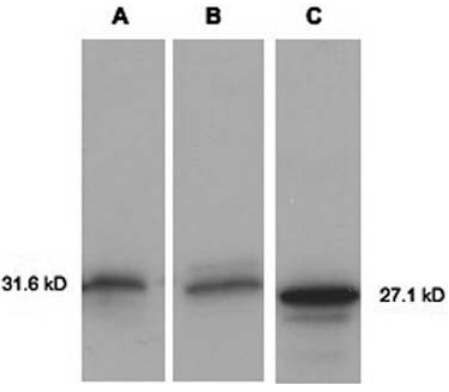
Figure 2. HT-GFP expression in P.berghei- HT infected BALB/C mouse whole blood lysates. Anti-GFP Western blots of ( A ) pL0016 (HT-GFP) ( B ) pL0016 ( D -GFP) whole blood lysates and ( C ) recombinant GFP alone.